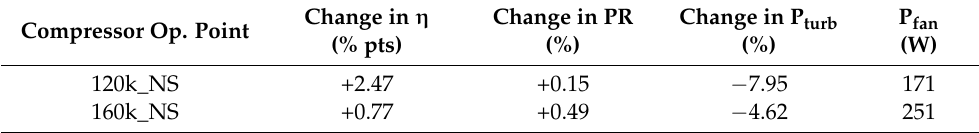
Table 3. Measured compressor stage performance with axial fan (normalized against “Unbladed” case). Compressor Op.